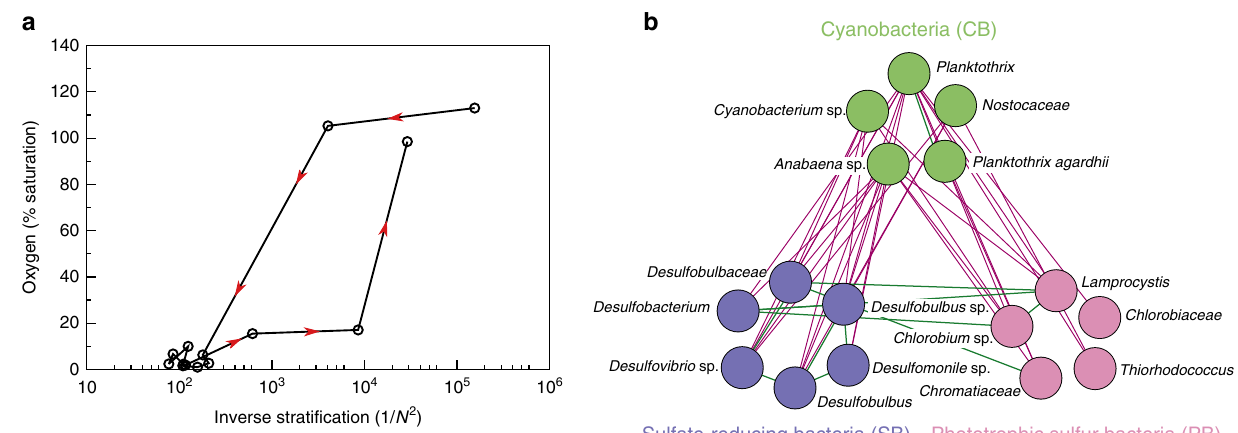
Fig. 6 Evidence for regime shifts between oxic and anoxic states in Lake Vechten. a Hysteresis loop of oxygen saturation in the hypolimnion (7 m depth) plotted against the inverse of the strati fi cation strength (1/ N 2 , where N 2 is the squared buoyancy frequency). The inverse of the strati fi cation strength provides a simple proxy of oxygen diffusivity across the thermocline (see Methods). Data points are from March 2013 to March 2014; red arrows indicate the direction of time. b Co-occurrence network of bacteria in the metalimnion, based on 16S rRNA sequence data. Green lines represent positive interactions (co-occurrence), whereas magenta lines represent negative interactions (mutual